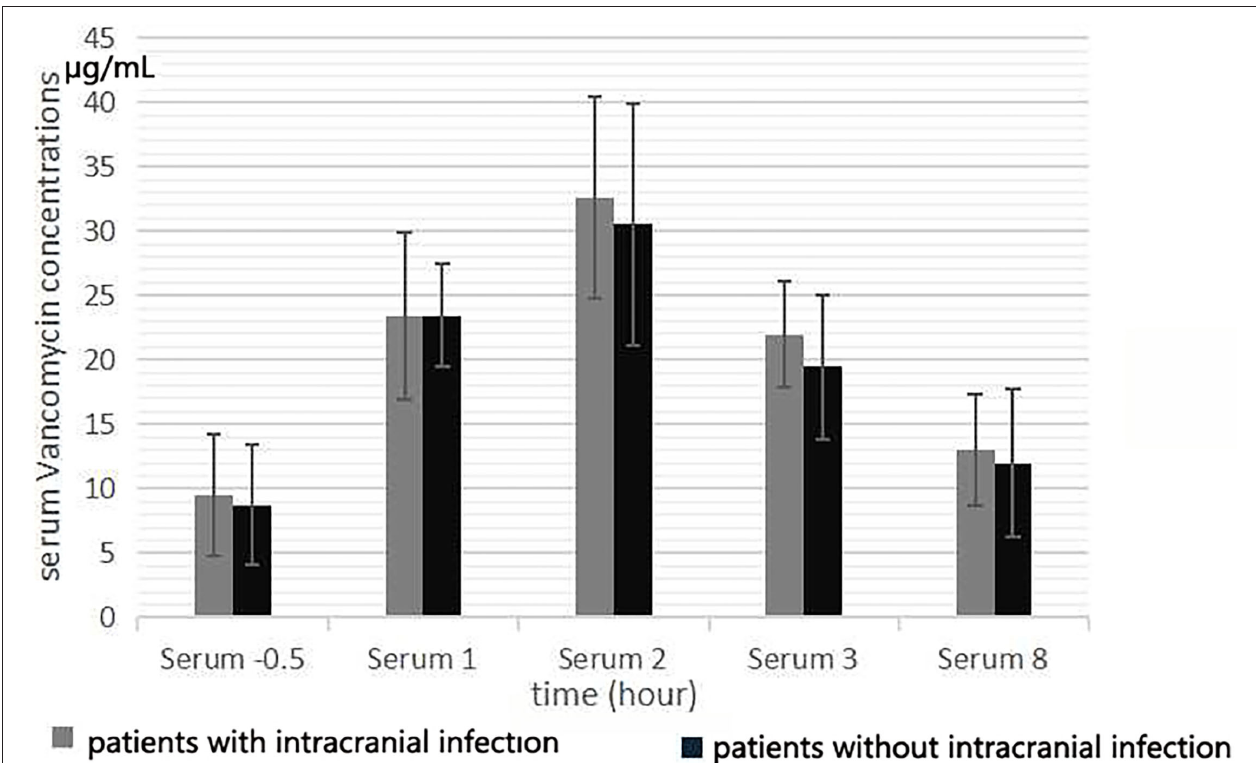
FIGURE 1 | Serum vancomycin concentration at 0.5h before the start of the fifth infusion, and 1, 2, 3, and 8h from the start of infusion.